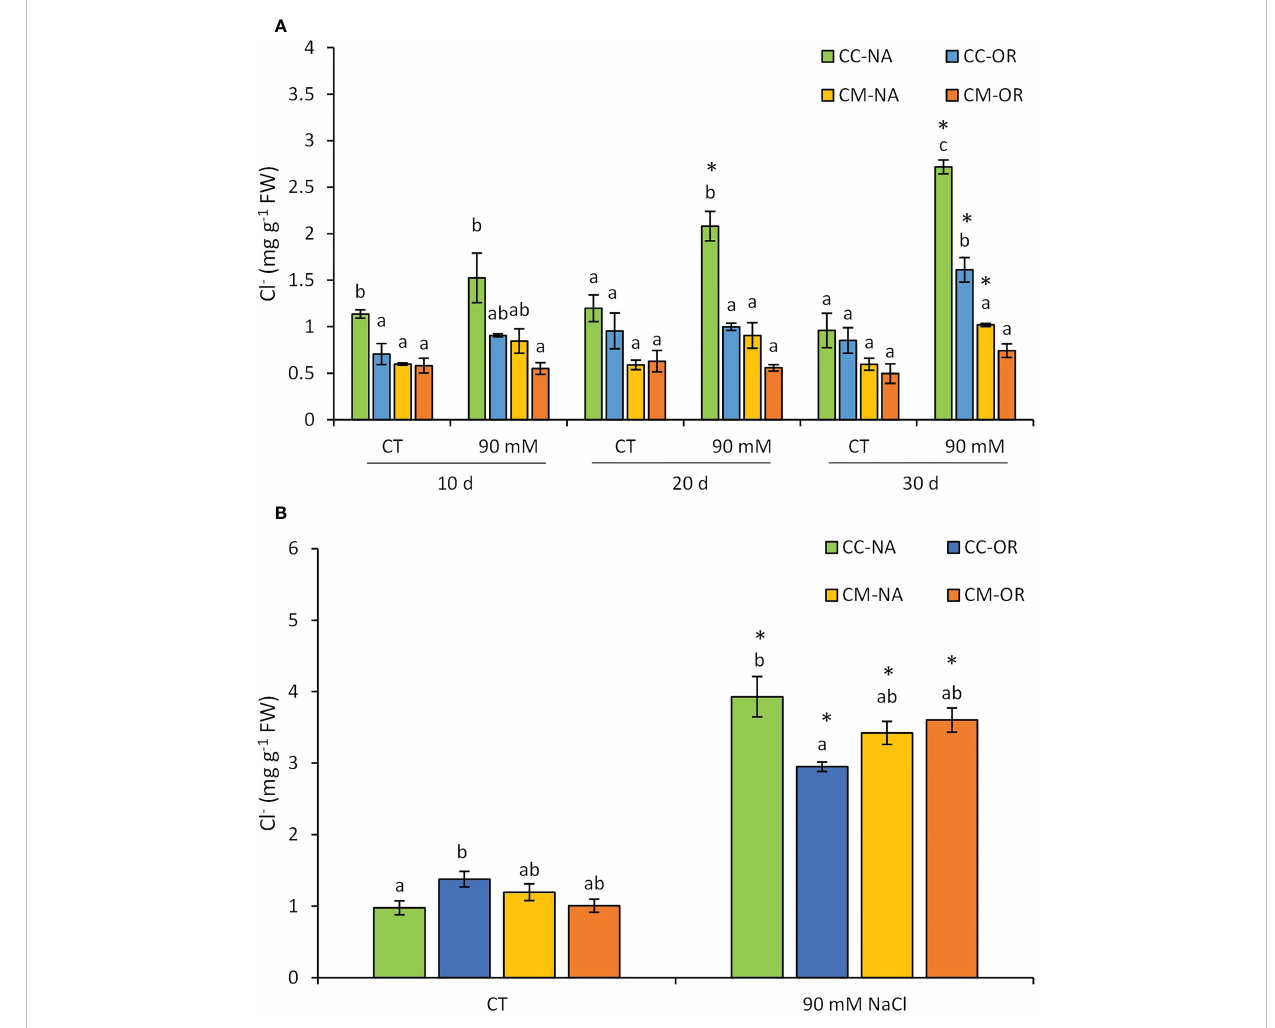
FIGURE 2 Leaf (A) and root (B) chloride content. Chloride ion content in leaves and roots of control and salt-stressed plants of CC-NA (green bars), CC-OR (blue bars), CM-NA (yellow bars), and CM-OR (orange bars). Values are the mean of three replicates ± standard error. Asterisks denote